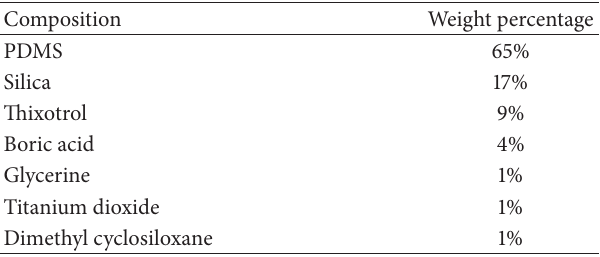
Table 1: The composition of Silly Putty